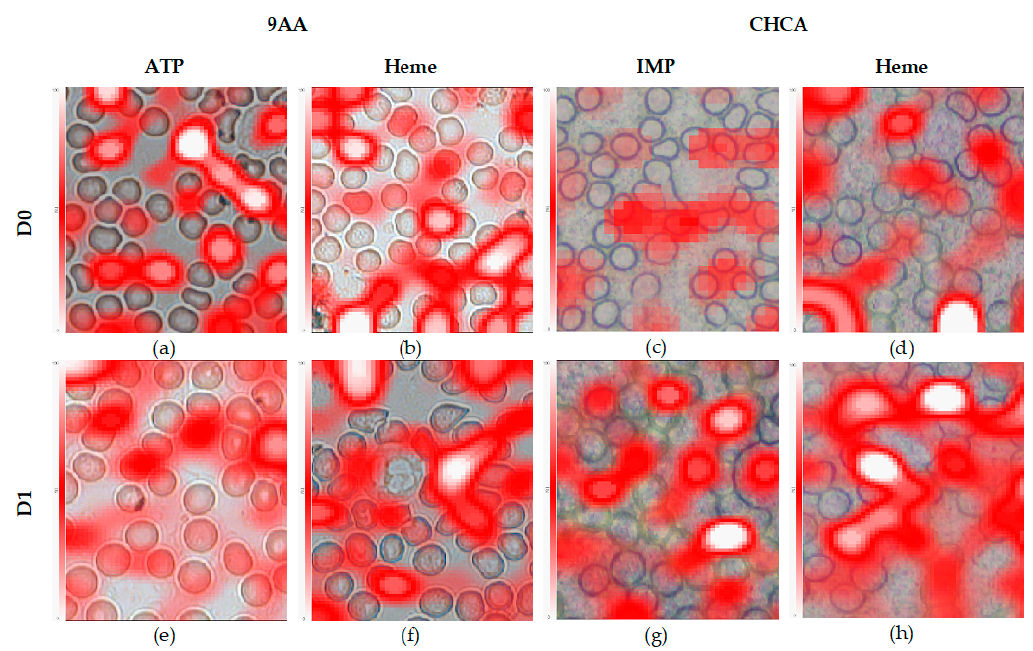
Figure 5. Lateral distribution of cellular markers overlaid on light microscopy images: ATP ( a , e ), heme ( b , d , f , h ), and inosine monophosphate (IMP) ( c , g ). MSI ( a – d ) was recorded using the selected D0, while images ( e – h ) were recorded using selected D1 settings. The 9AA matrix and negative ionization were used for recording images ( a , b , e , f ). The CHCA matrix and positive ionization were used for recording images ( c , d , g , h ). Scale bar corresponds to 5 μ m.